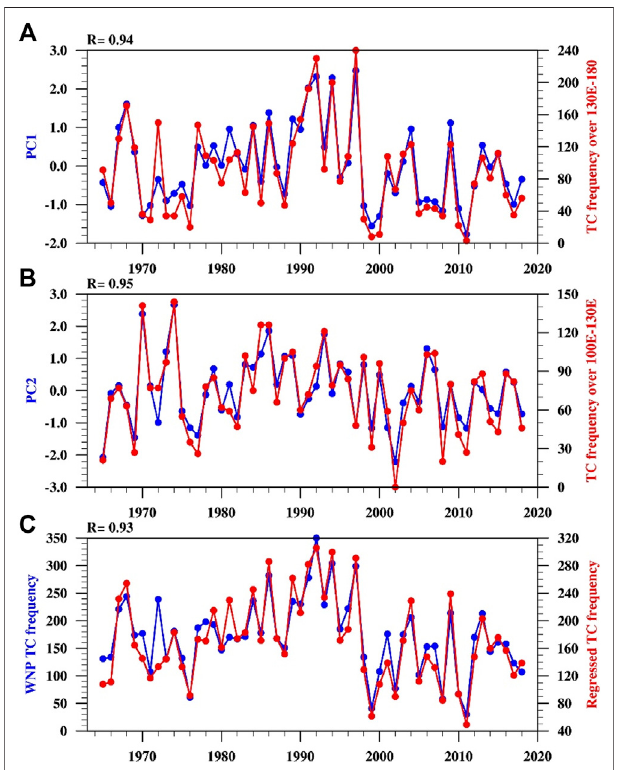
FIGURE2| Timeseriesof (A) principalcomponentofthe fi rstEOFmode (blue line) and TC track frequency over the eastern WNP (0 ° – 40 ° N, 130 ° E- 180 ° ), (B) principal component of the second EOF mode (blue line), and TC track frequency over the western WNP (0 ° – 40 ° N, 100 ° E-130 ° E), (C) observed (blue line) and simulated (red line) TC track frequency over the WNP (0 ° – 40 ° N, 100 ° E-180 ° ) during 1965 – 2018.